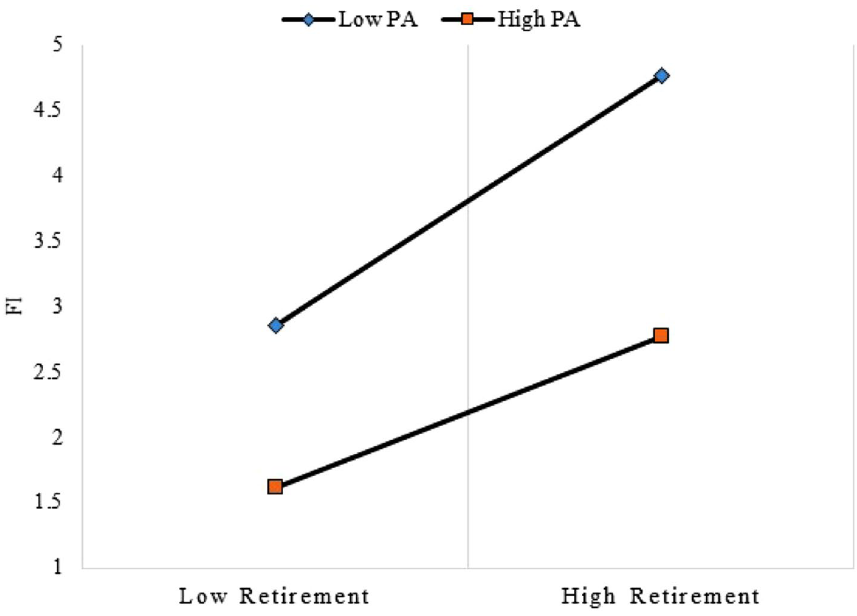
Figure 2. Physical activity (PA, the moderator) dampens the association of retirement with functional impairment (FI) in the overall sample.